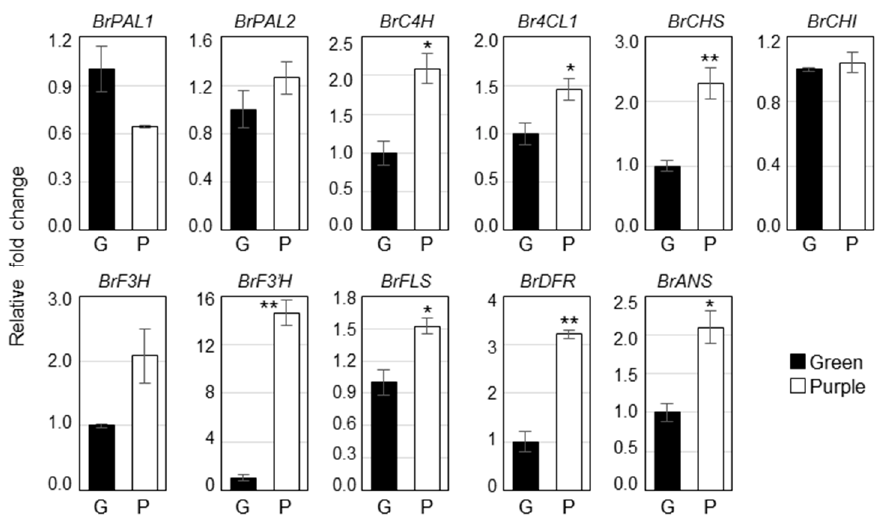
Figure 3. Expression of the phenylpropanoid biosynthetic genes in green and purple pakchoi. Total RNA isolated from 2-month-old green and purple pakchoi were subjected to quantitative real time RT-PCR. Relative fold changes were plotted after normalization to EF1 α . The means ± S.E. from three biological and technical replicate experiments were plotted. Asterisks indicate significant differences compared with the green pakchoi using Student’s t test (* p < 0.05; ** p < 0.01). PAL , phenylalanine ammonia-lyase; C4H , cinnamate 4-hydroxylase; 4CL , 4-coumarate-CoA ligase; CHS , chalcone synthase; CHI , chalcone isomerase; F3H , flavanone-3-hydroxylase; F3 (cid:48) H , flavonoid-3 (cid:48) -hydroxylase; FLS , flavonol synthase; DFR , dihydroflavonol reductase; ANS , anthocyanin synthase. Table 1. Phenylpropanoid contents in green and purple pakchoi ( µ g g − 1 dry